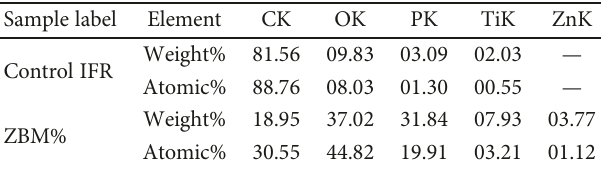
Figure 20: Energy spectrum pictures of Control IFR and ZBM2%. Table 5: EDS results of Control IFR and